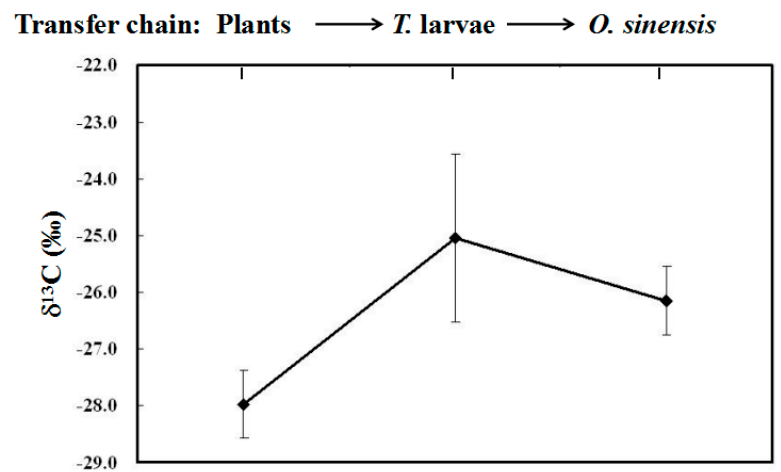
Figure 4. Variation of the stable carbon isotope ratios ( δ 13 C) of the bulk samples of plants, larvae and O. sinensis.